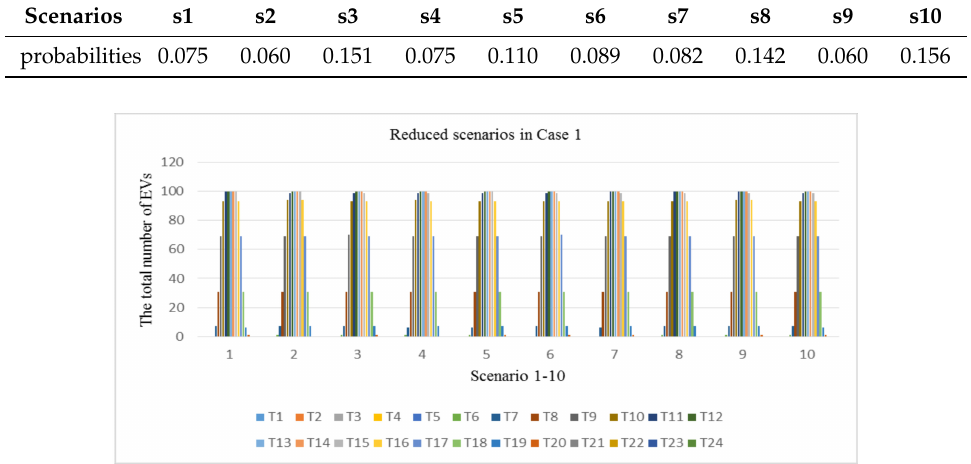
Table 2. The probabilities of reduced scenarios in Case 1.